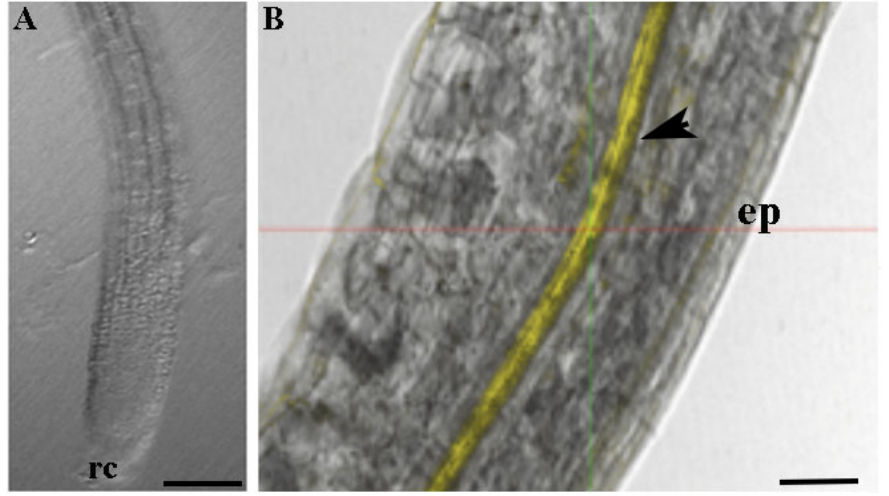
Figure 4. Confocal laser scanning microscopy images ( A ) non ‐ treated and ( B ) treated with Rhodamine ‐ B ‐ labelled CTNPs. ( B ) Yellow signal is localized in the xylem of Arabidopsis root (arrowhead). ep: Epidermis; rc: Root cap. Scale bars ( A ) 150 μ m; ( B ) 70 μ m.